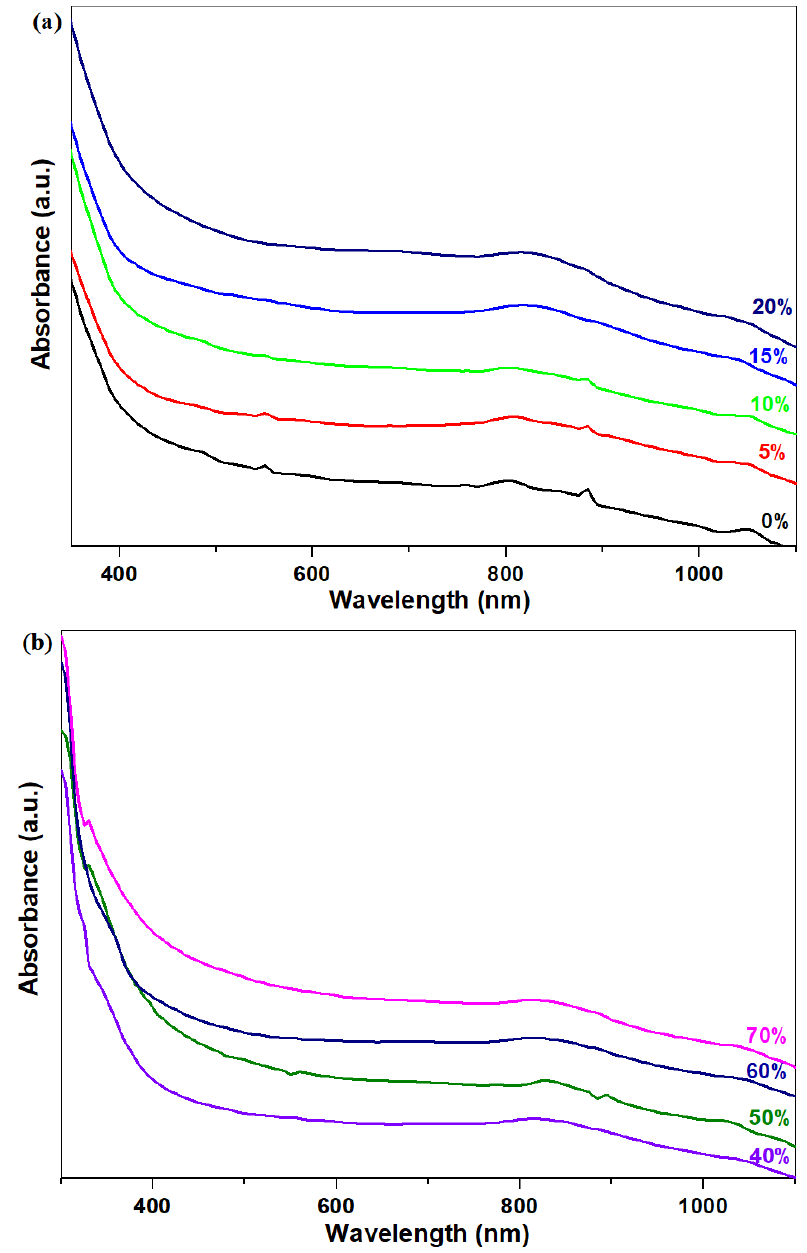
Figure 3. UV-Vis spectra of the vitreous system with the xNaH 2 PO 4 ·5MnO 2 ·(95 − x)[4PbO 2 ·Pb]